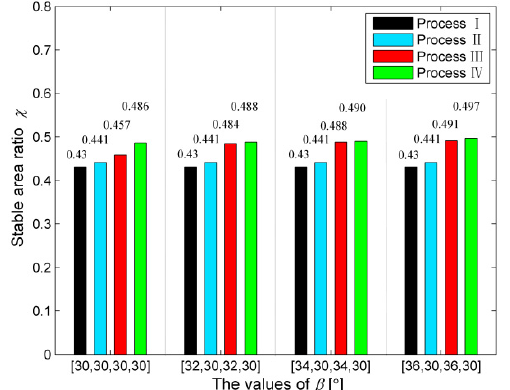
χ Figure 9. Comparison of the values of χ corresponding to the SLDs in Figure Figure 9. Comparison of the values of corresponding to the SLDs in Figure 8.